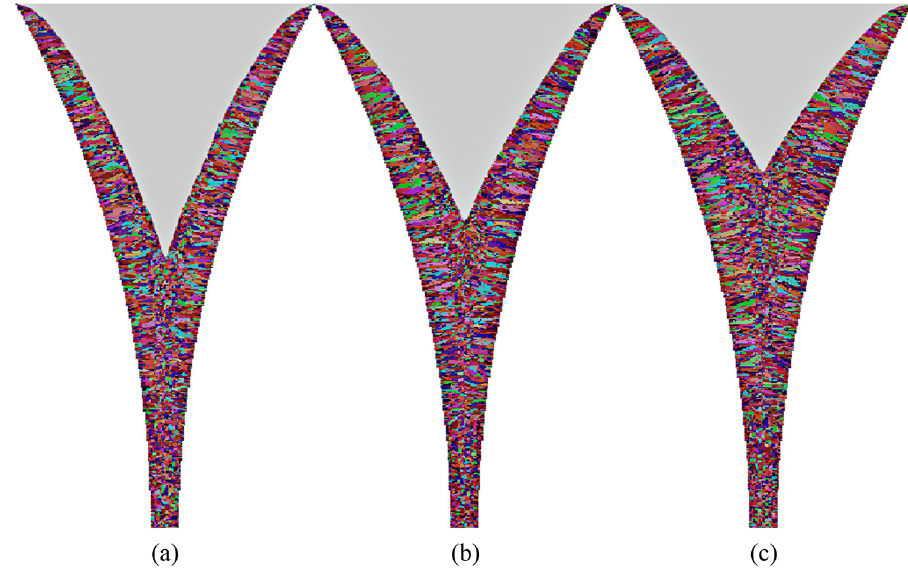
Figure 5: Solidi fi cation structure at di ff erent interfacial heat transfer coe ffi cients. ( a ) 4,000 W · m − 2 · k − 1 , ( b ) 5,500 W · m − 2 · k − 1 , and ( c ) 7,000 W · m − 2 · k − 1 .